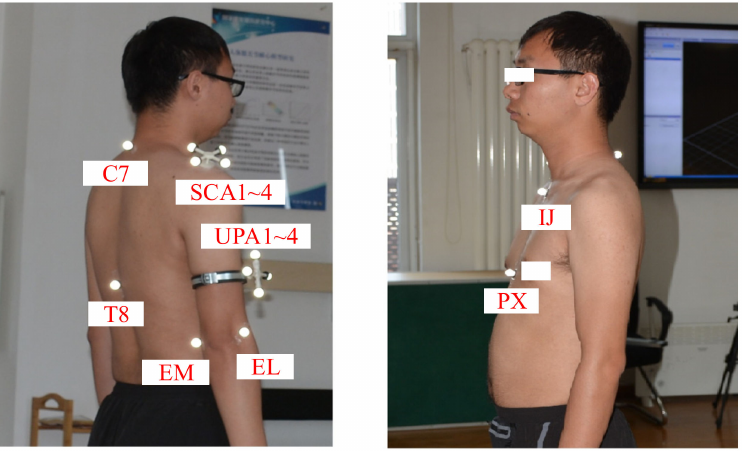
Figure 4. Marker placements of